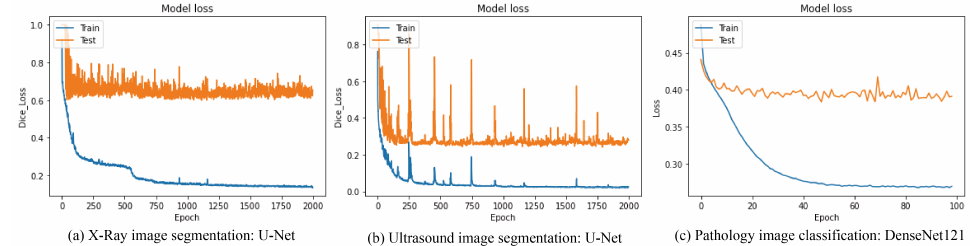
Figure 6. Training Procedures of each operation.